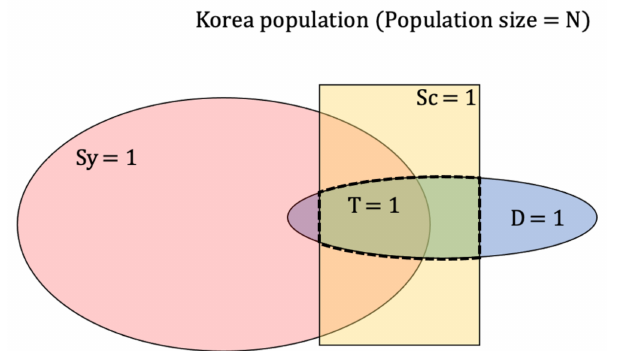
Figure 1. Representing four random variables Disease (D), Symptoms (Sy), Screening (Sc), Test result (T) as a diagram when PPV = 1 and NPV = 1. T is defined in a population where Sc = 1 and D =